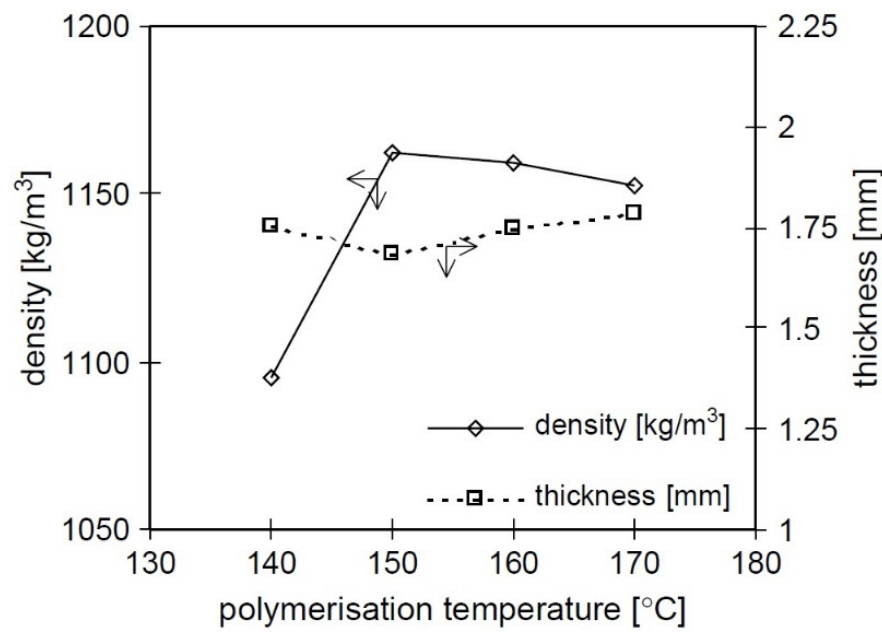
Figure 8. Density and panel thickness for various polymerization temperatures. Reprinted from Reference [10], under open-access license.